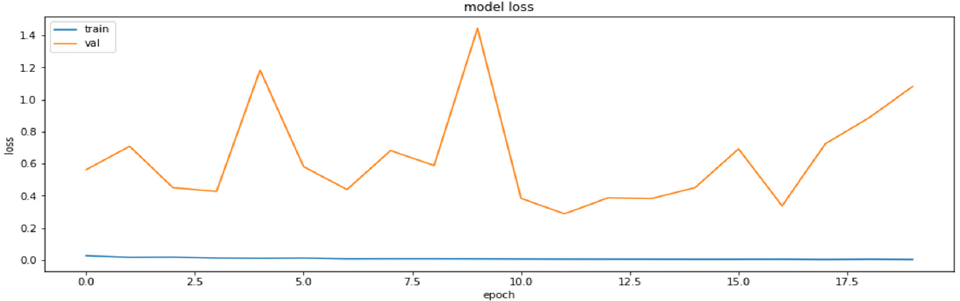
Figure 3. The loss function values on the training datasets obtained by polynomial iterative pruning of the model.